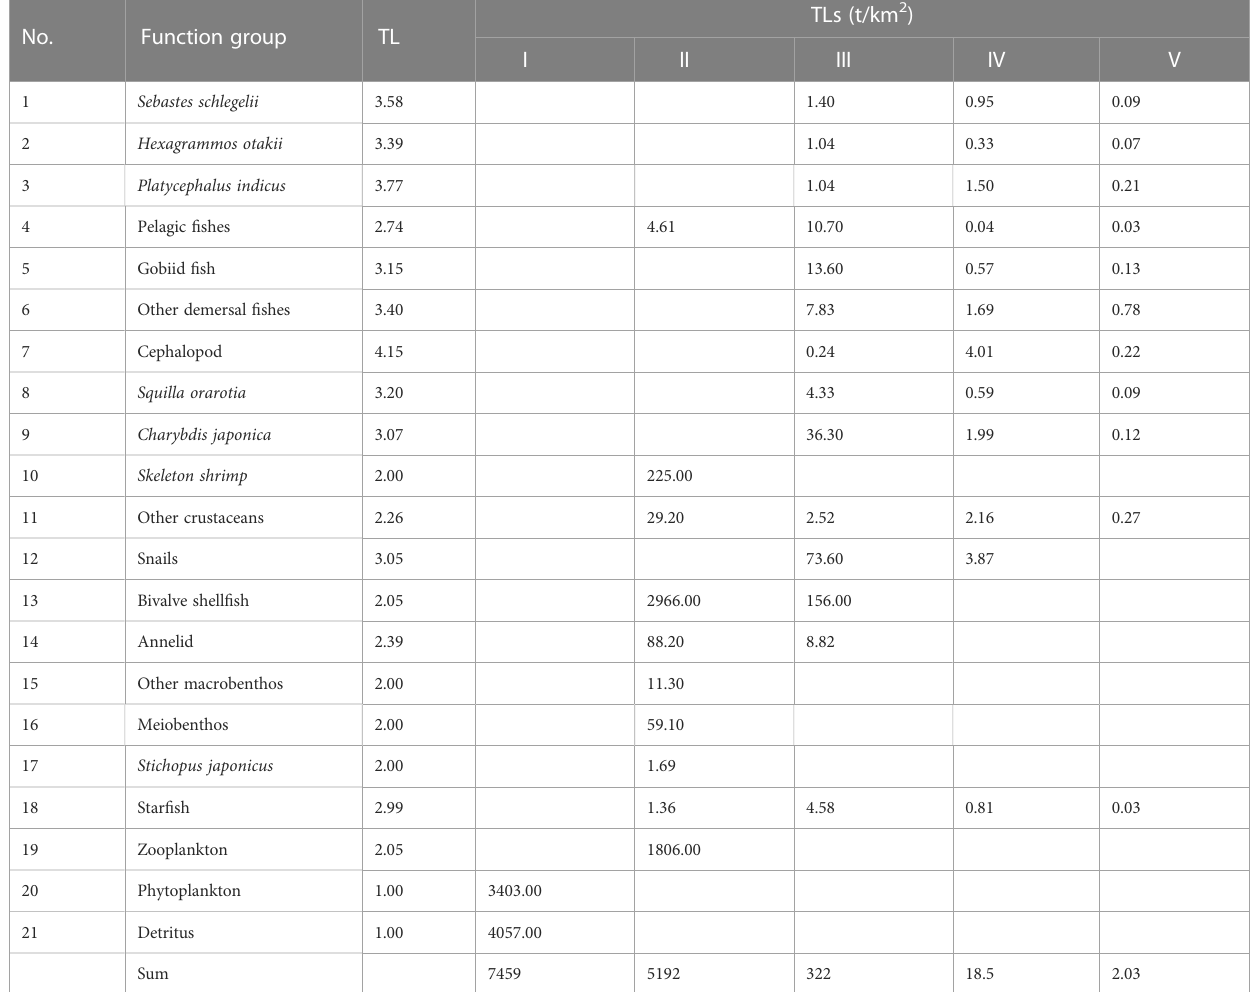
TABLE 4 Trophic fl ow matrix of the study marine ranching ecosystem according to model groups and TLs.